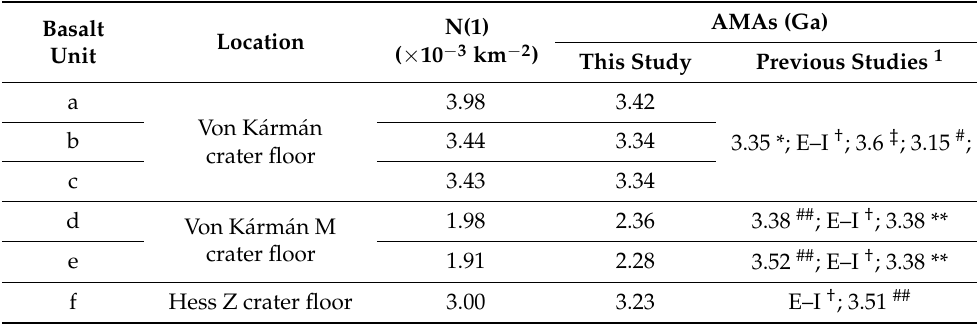
Table 1. Results of AMAs for the groups of basalt units in this study.